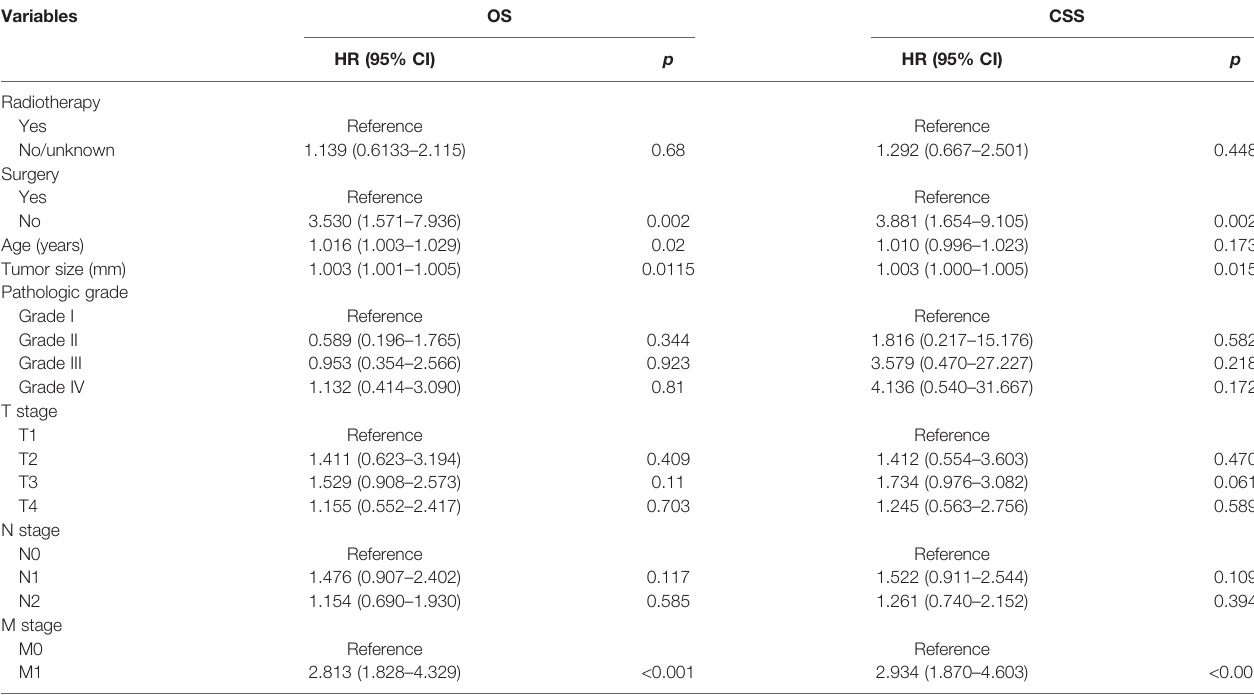
TABLE 5 | DAG-guided multivariable Cox regression model analysis of causal effect of radiotherapy on OS and CSS.